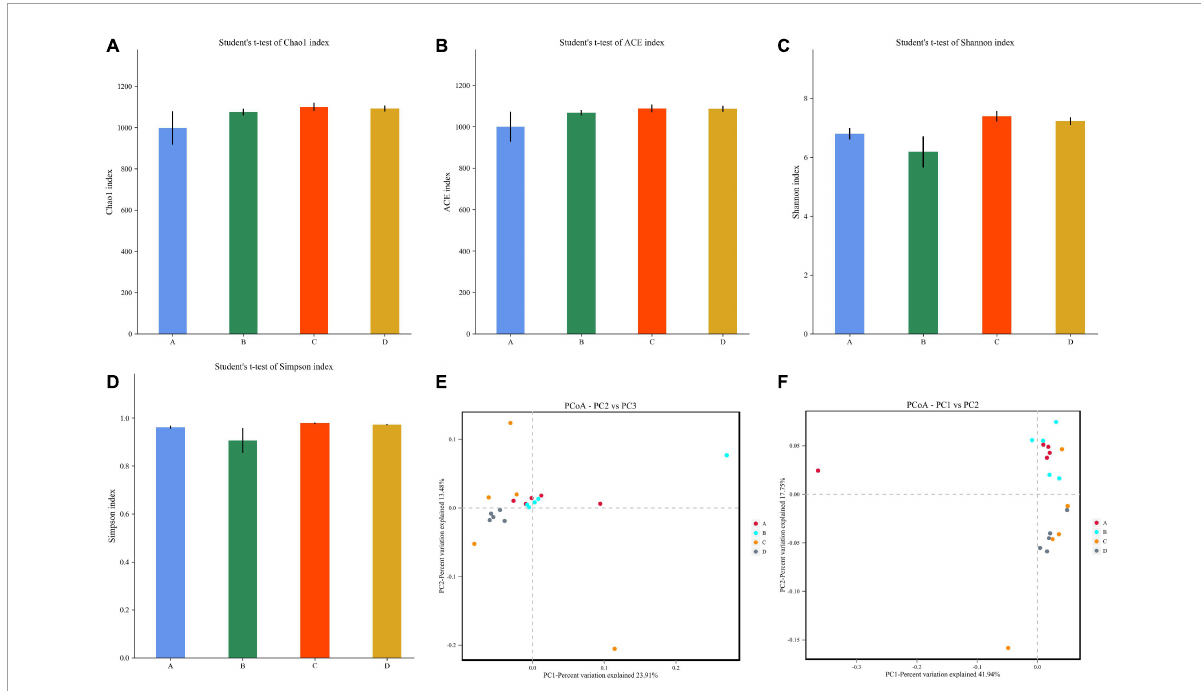
FIGURE2 Comparative analysis of microbial diversity between control and black soldier fly oil treatment groups. (A–D) Represent Chao, ACE, Shannon and Simpson indices, respectively. (E,F) Represent scatterplot from PCoA based on weighted and unweighted UniFrac